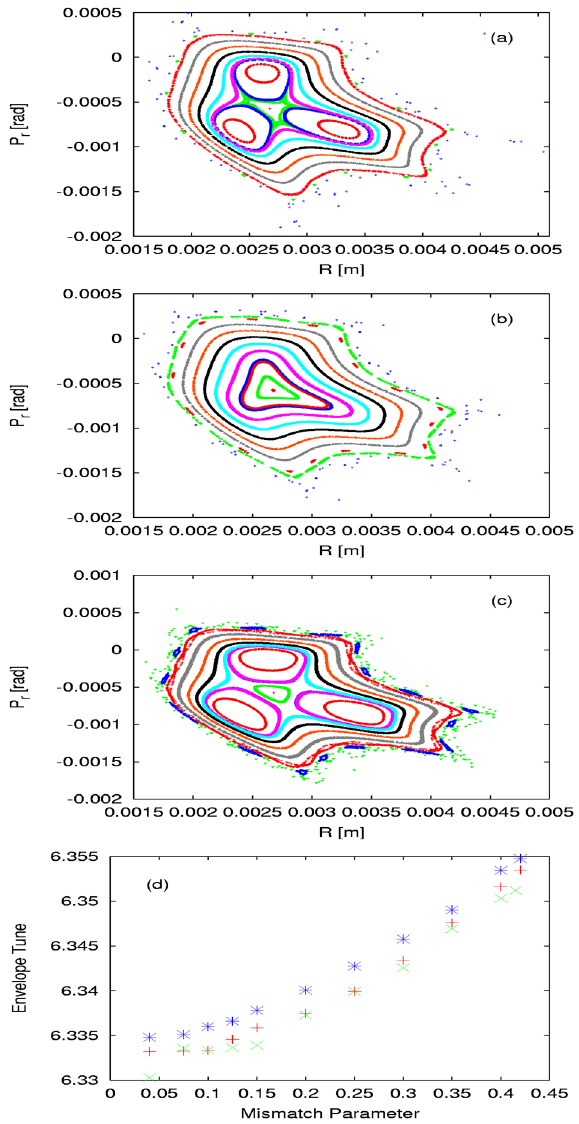
FIG. 11. (Color) (a) Horizontal stroboscopic map of a